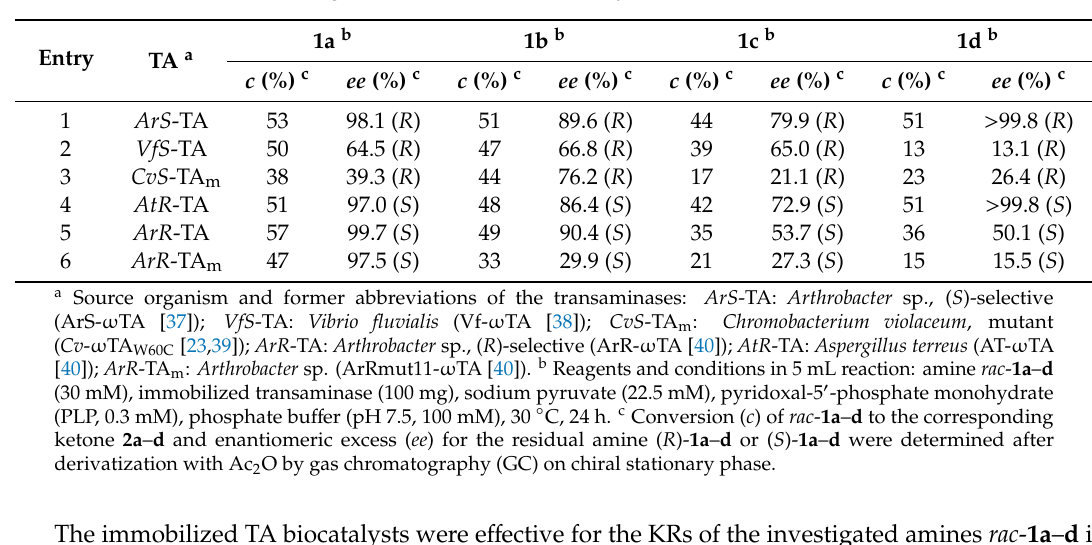
Table 1. Shake vial screening of immobilized TA biocatalysts in kinetic resolution of amines rac - 1a – d